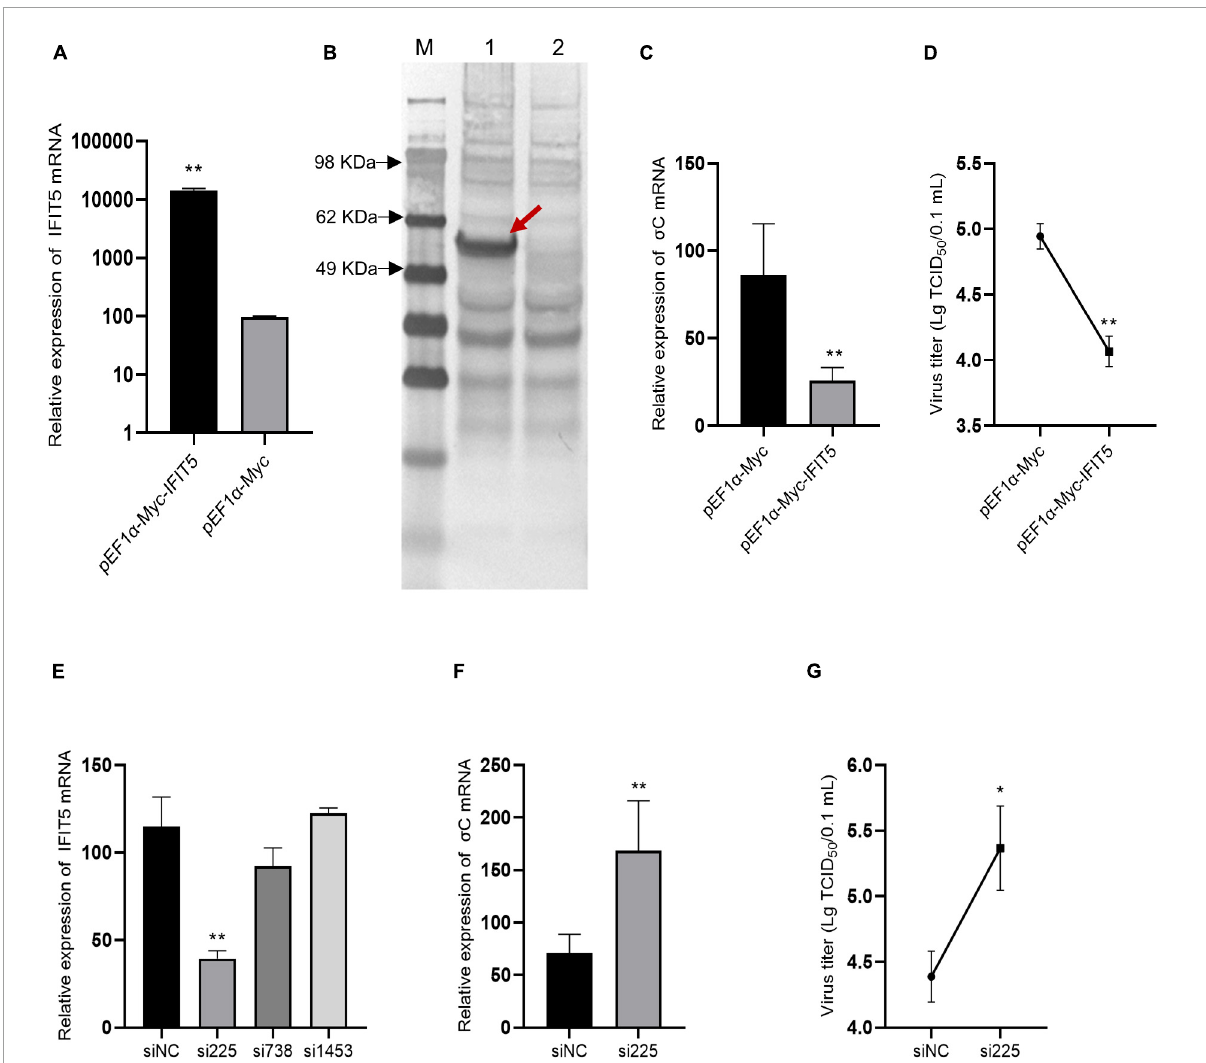
FIGURE8 IFIT5 inhibits ARV replication in DF-1 cells. DF-1 cells were transfected with pEF1 α -Myc-IFIT5 or pEF1 α -Myc plasmids. Both real-time quantitative PCR (A) and Western blotting (B) confirmed that IFIT5 was highly expressed in DF-1 cells. DF-1 cells were transfected with pEF1 α -Myc-IFIT5 or pEF1 α -Myc plasmid and infected with ARV strain S1133 (MOI = 1). Viral replication was measured by real-time quantitative PCR (C) and viral titers (D) at 24 h after infection. The inhibitory efficiency of three IFIT5 siRNAs was compared by real-time quantitative PCR (E) . DF-1 cells were transfected with si225 or siNC and infected with ARV strain S1133 (MOI = 1). Viral replication was measured by real-time quantitative PCR (F) and viral titers (G) at 24 h after infection. The data are the mean ± SD of three independent experiments. Asterisks indicate significant differences (* P < 0.05, ** P <